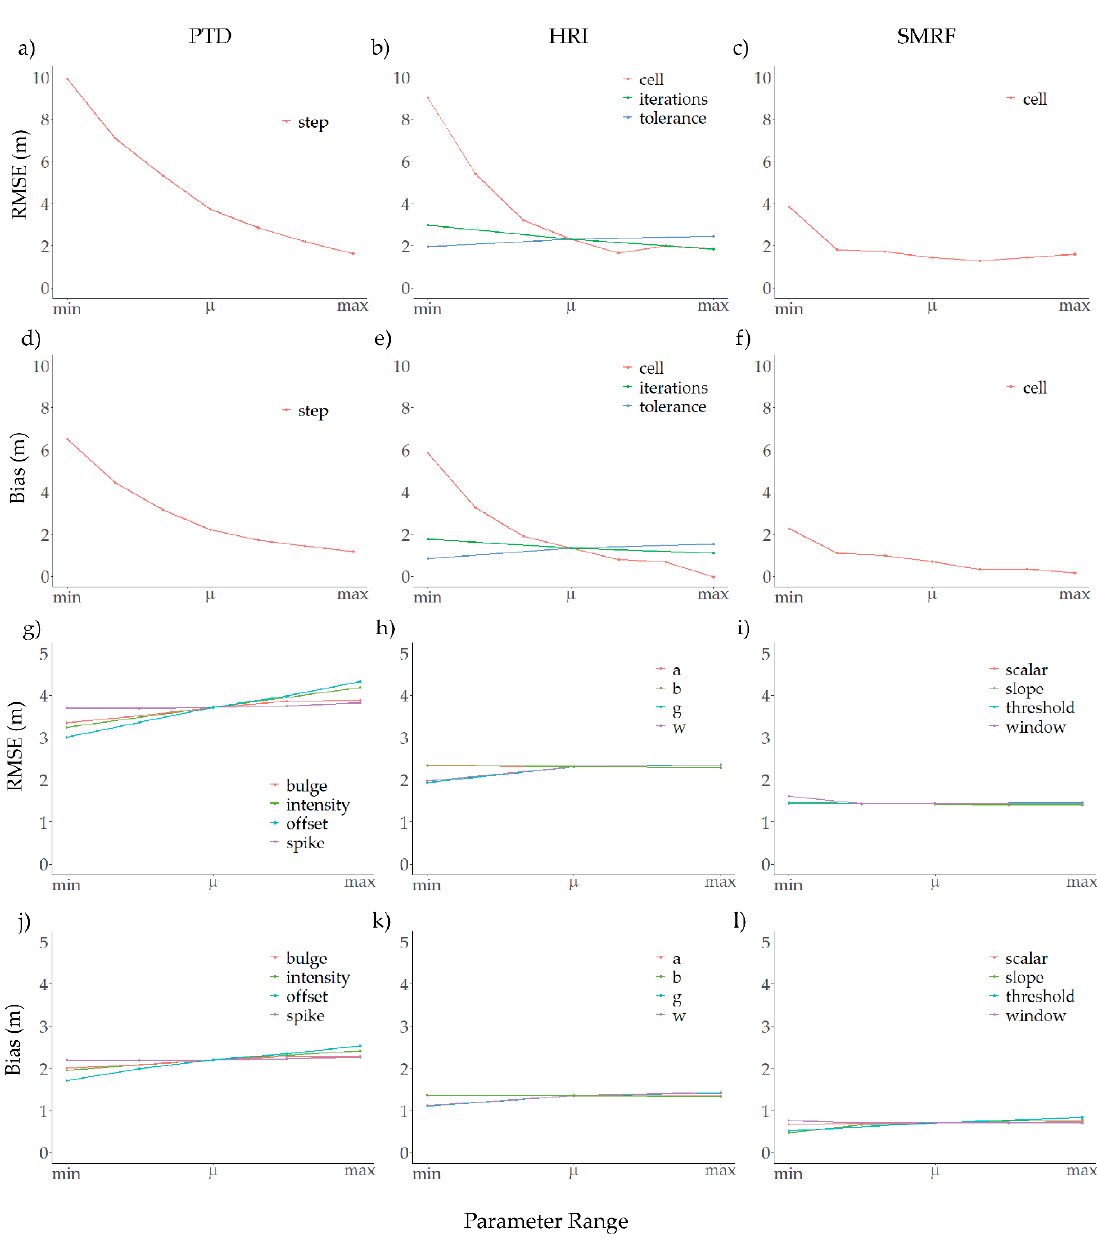
Figure 5. Sensitivity analysis results of ALS ground points vs. DAP DEM surface elevations using ground classification methods PTD ( a , d , g , j ); HRI ( b , e , h , k ); and SMRF ( c , f , i , l ). Varied parameter ranges are combined in a relative scale. Table 5. Ground classification algorithms, parameter descriptions and values used for testing on 1 ha stratified